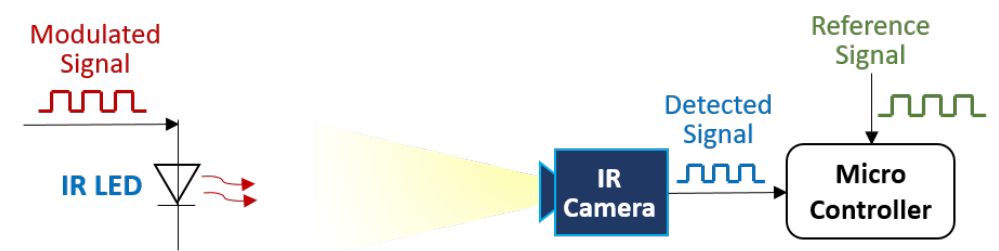
Figure 5. Schematic of the signal modulation for the transmitter (IR LED) and the receiver (IR camera with a Microcontroller).